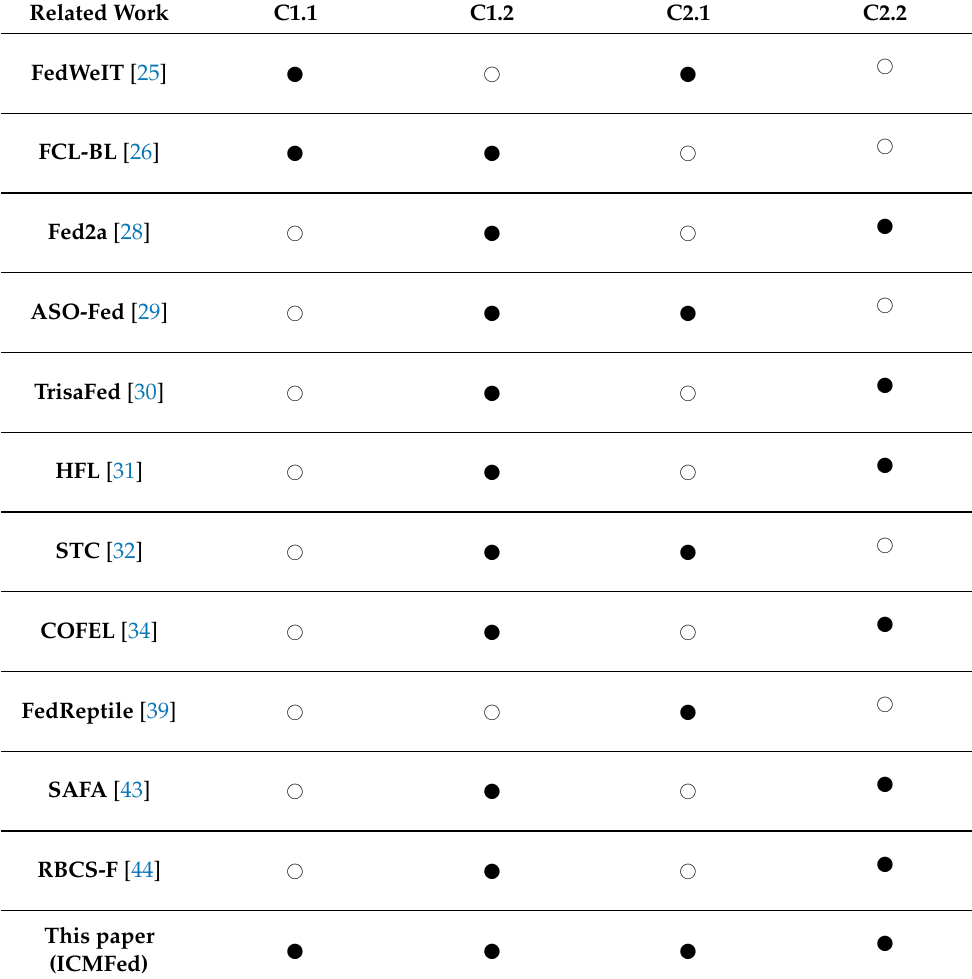
Table 1. Cont. Related